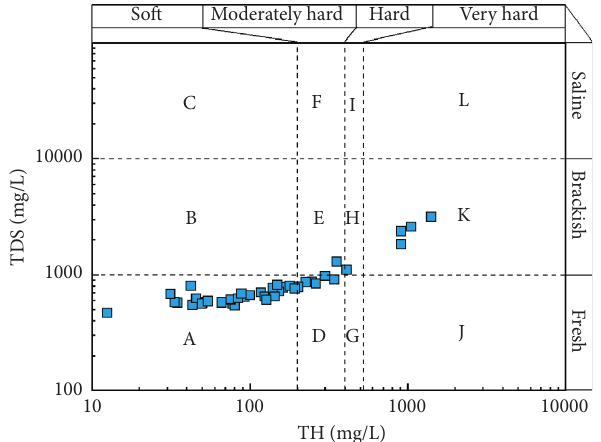
Figure 4: Scatter plots of total hardness (TH) versus total dissolved solids (TDS) showing the quality of groundwater.